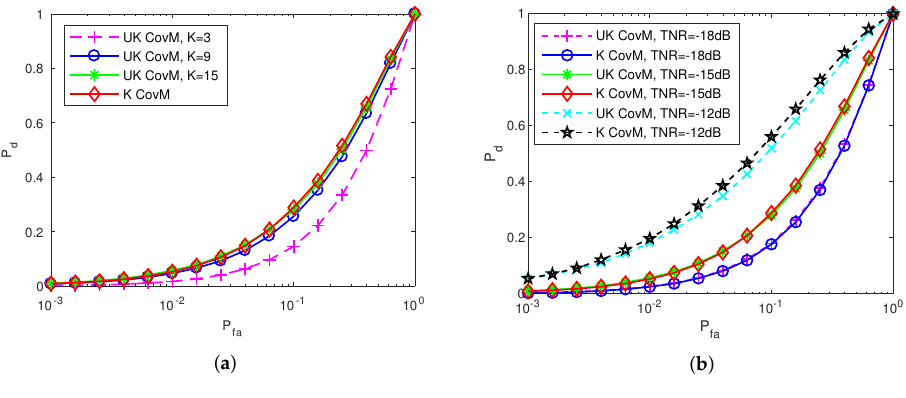
Figure 2. P d vs. P fa . ( a ) TNR = − 15 dB. ( b ) K = 15.